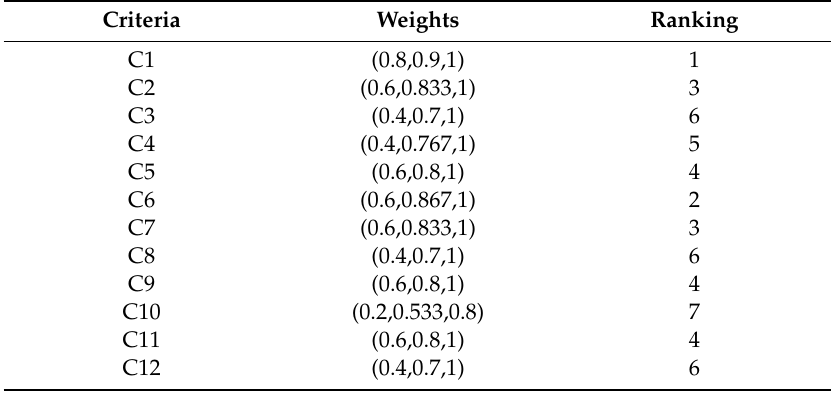
Table 18. Ranking of criteria’s weights.